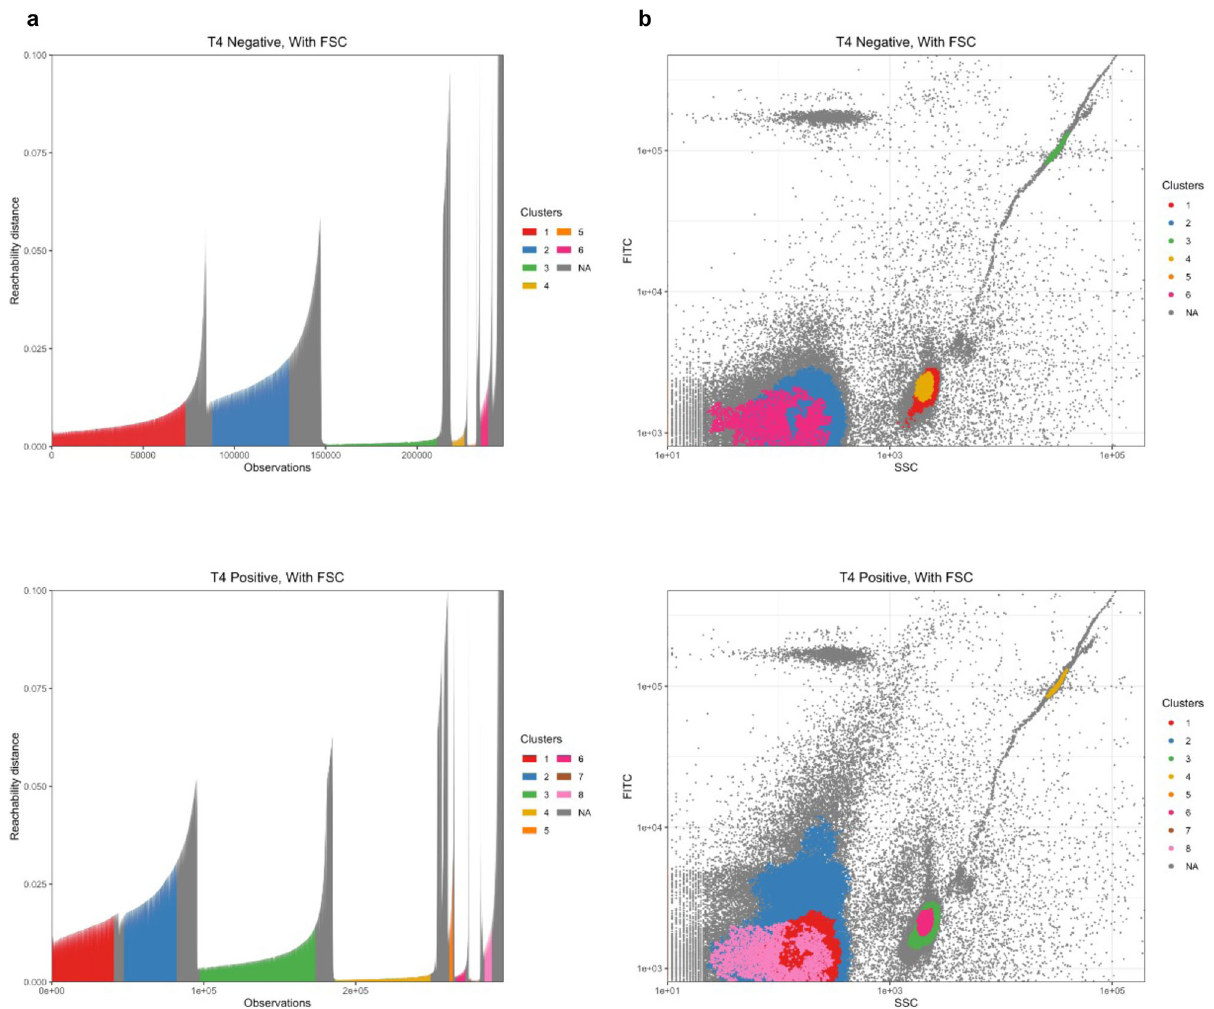
Fig. 8 Representative results of manually extracting clusters from OPTICS-ordered data collected from environmental-spike experiments, with the FSC dimension included in the OPTICS ordering. Panel a plots show the OPTICS ordering of the data from which the clusters were manually extracted. Colors highlight each manually extracted cluster. Panel b plots visualize the data as SSC vs. FITC plots, with points colored based on the cluster extraction. Cluster colors are consistent between the two plots for each of the T4-spiked and unspiked experiments, but not necessarily across experiments. Some clusters are not visually apparent on the scatterplots because they include low-SSC points collapsed onto the y